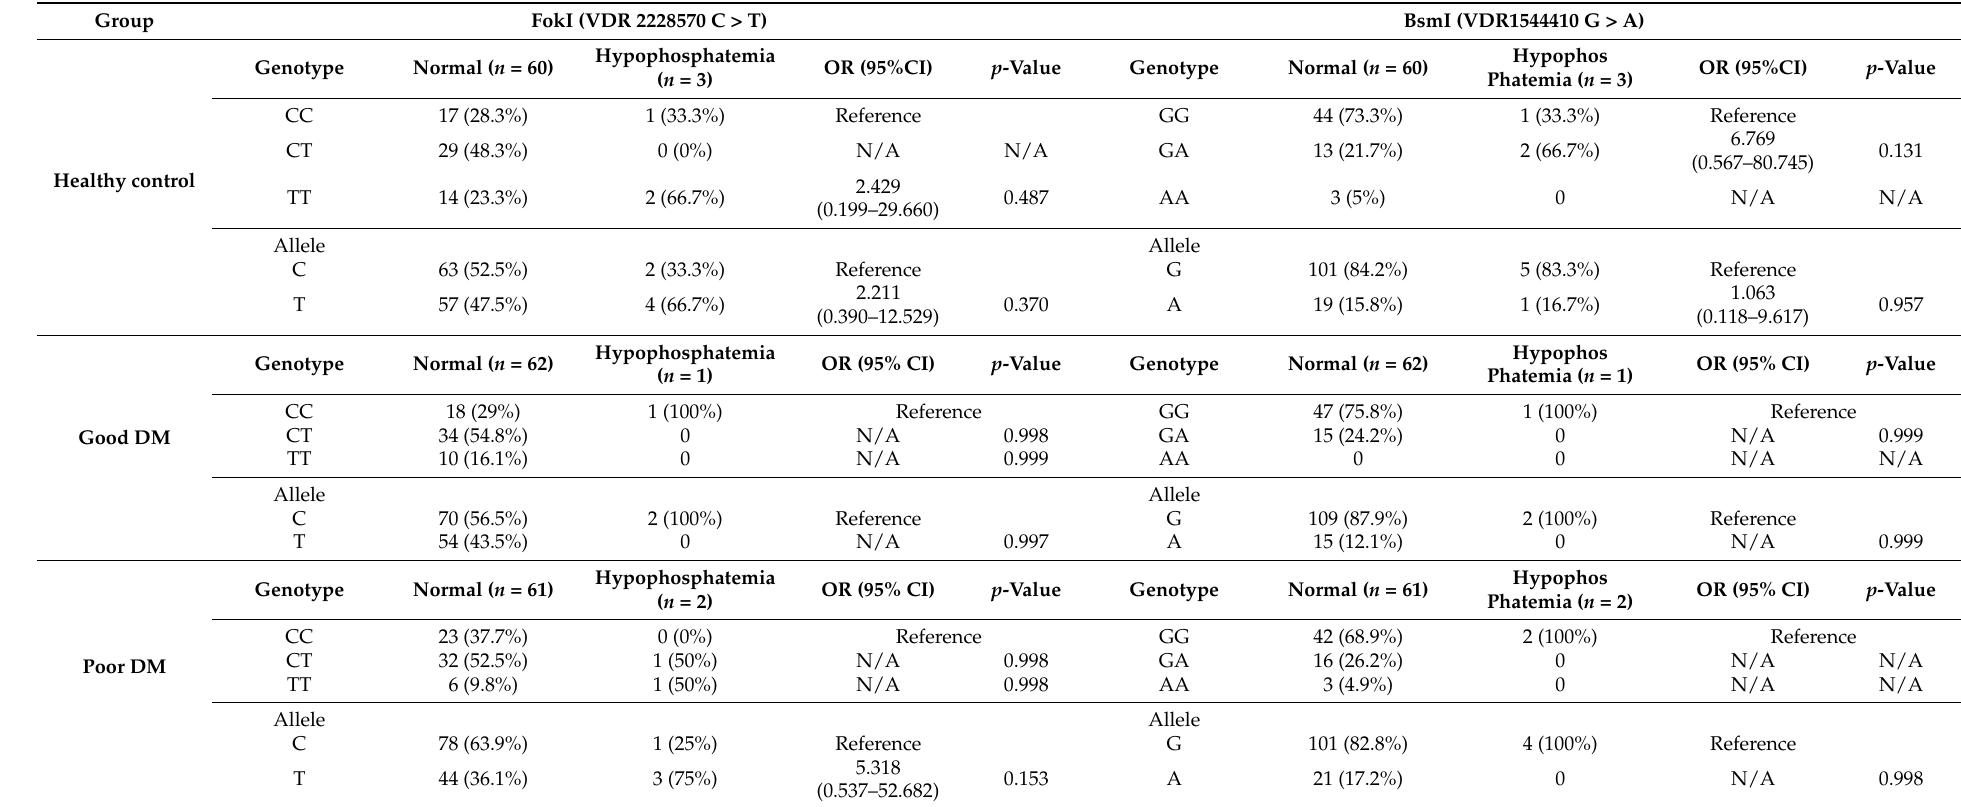
Table 8. Association between VDR polymorphism at FokI (VDR 2228570 C > T) and BsmI (VDR1544410 G > A) and risk of